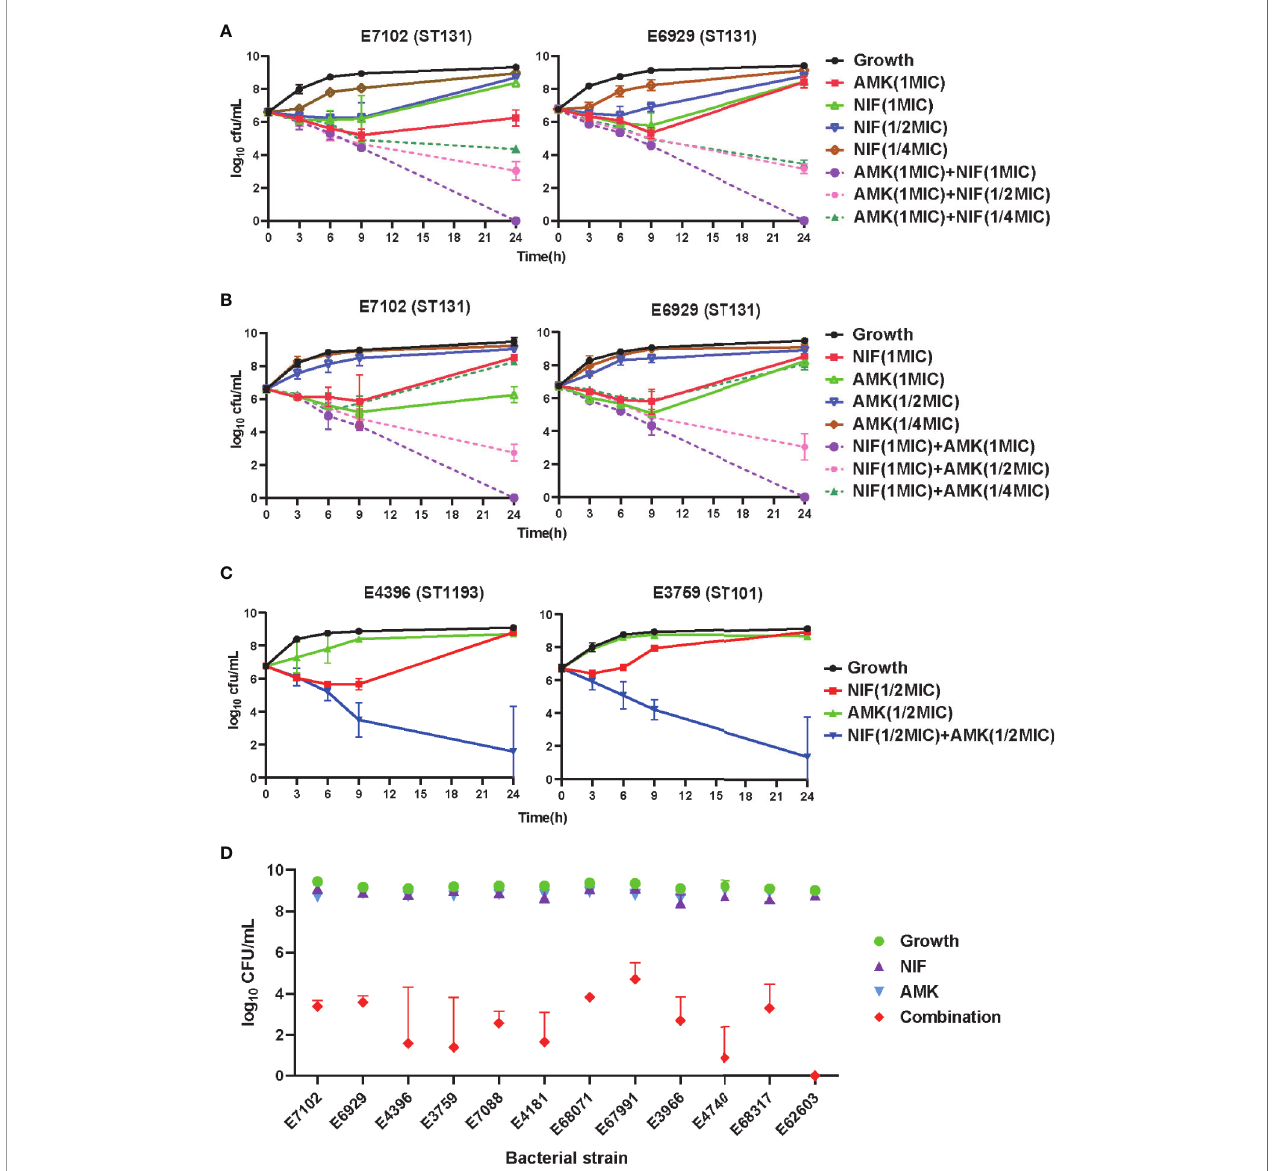
FIGURE 2 | In vitro time – kill curves using amikacin and nitrofurantoin alone and in combination against the indicated test strains. (A – C) Combinatorial bactericidal activity of amikacin and nitrofurantoin against ST131 UPEC strains. Mean ± standard error from three independent experiments are shown. AMK, amikacin; NIF, nitrofurantoin. (D) Growth after 24 h for all the test strains using amikacin and nitrofurantoin alone and in combinations compared to the